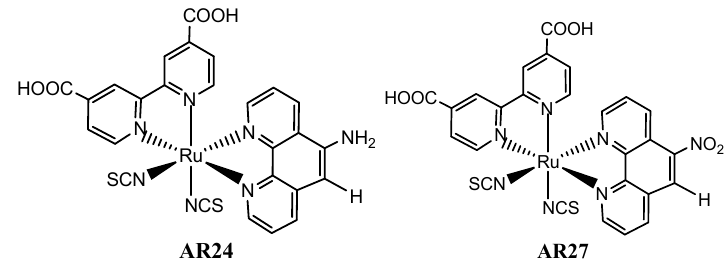
Figure 17. Ruthenium polypyridyl complexes with different ligand